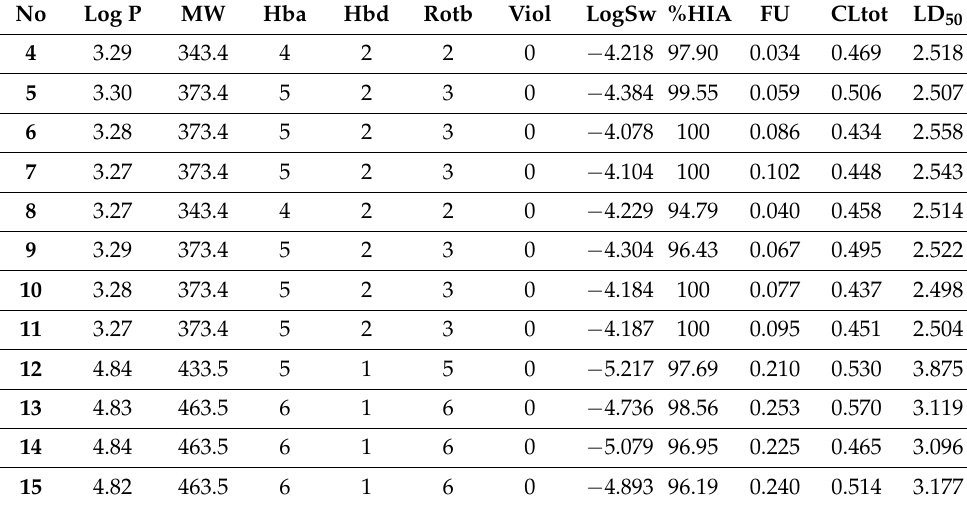
Table 1. In silico evaluation of physicochemical properties of compounds 4 – 15